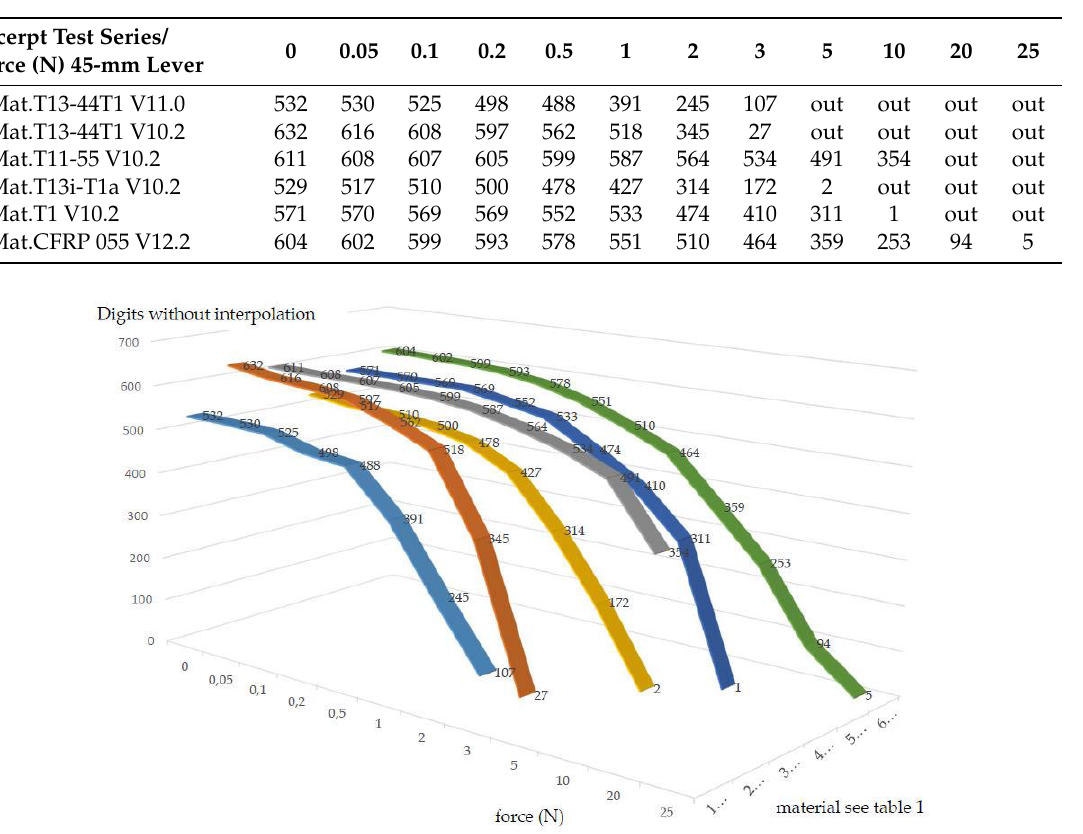
Figure 7. Visualized, measured values from Table 1.